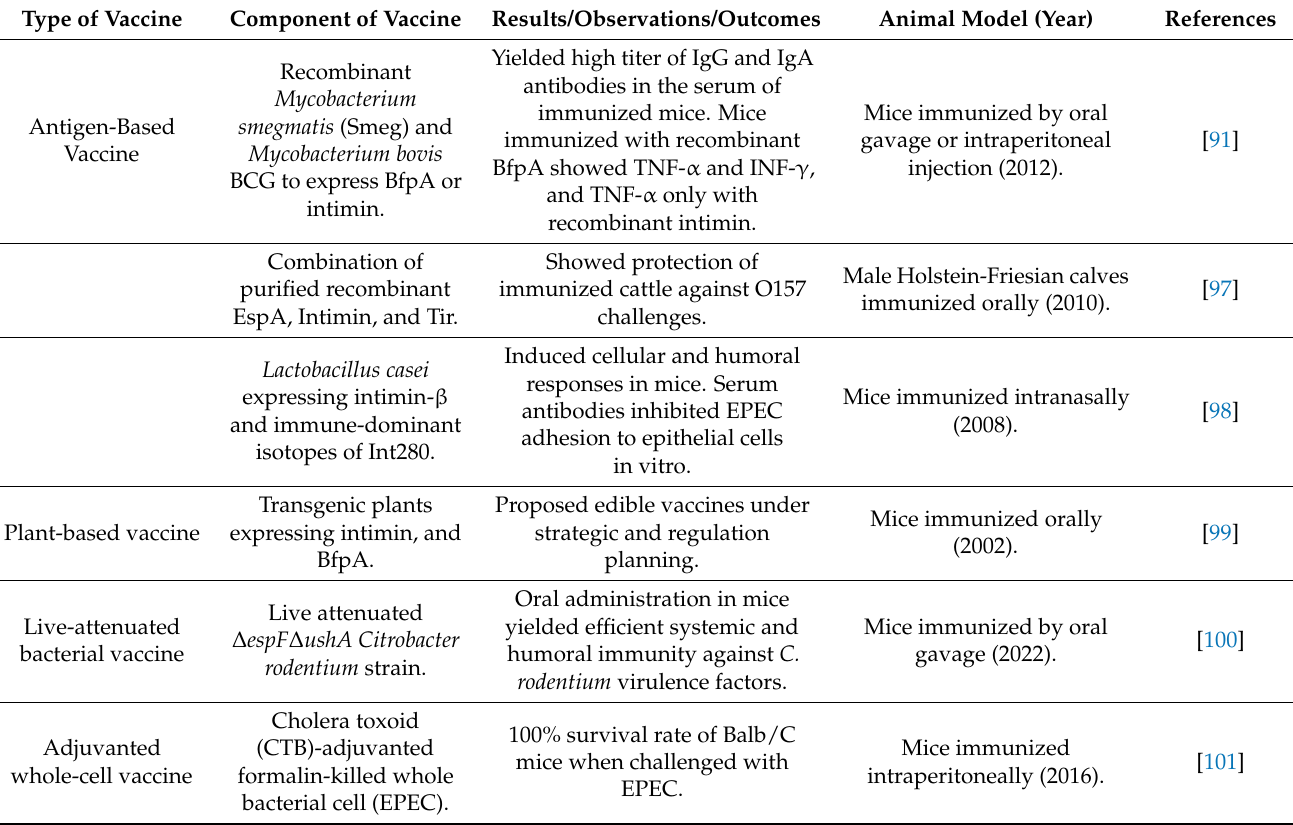
Table 1. Reports describing vaccines against Enteropathogenic E. coli